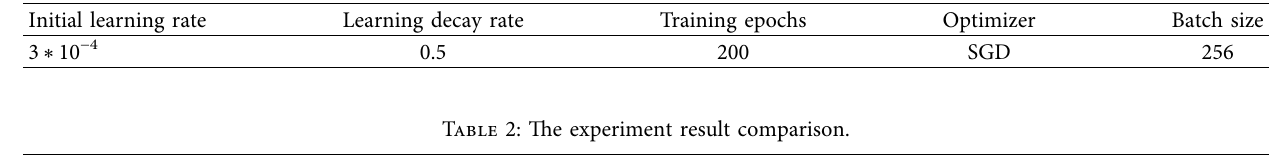
Table 1: Hyperparameters of the